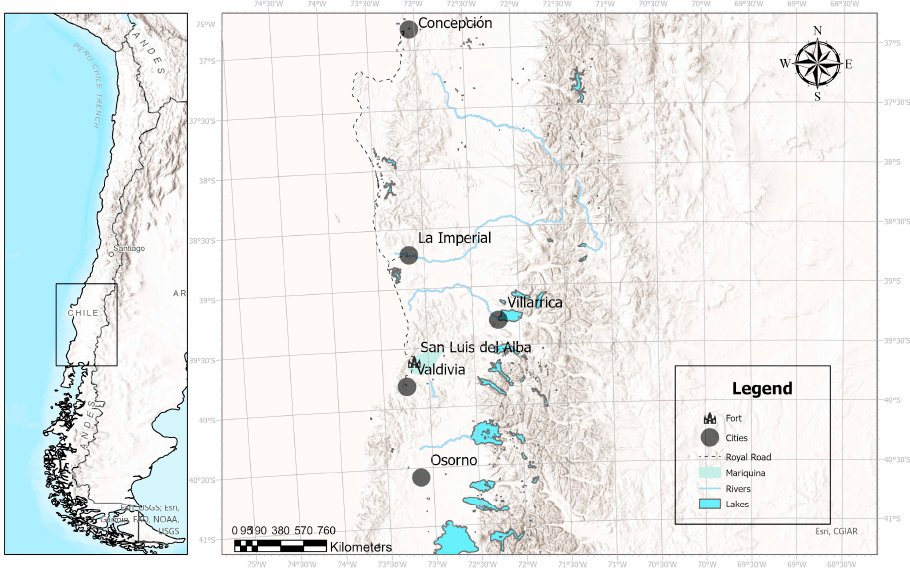
Figure 1. San Luis del Fort and Mariquina